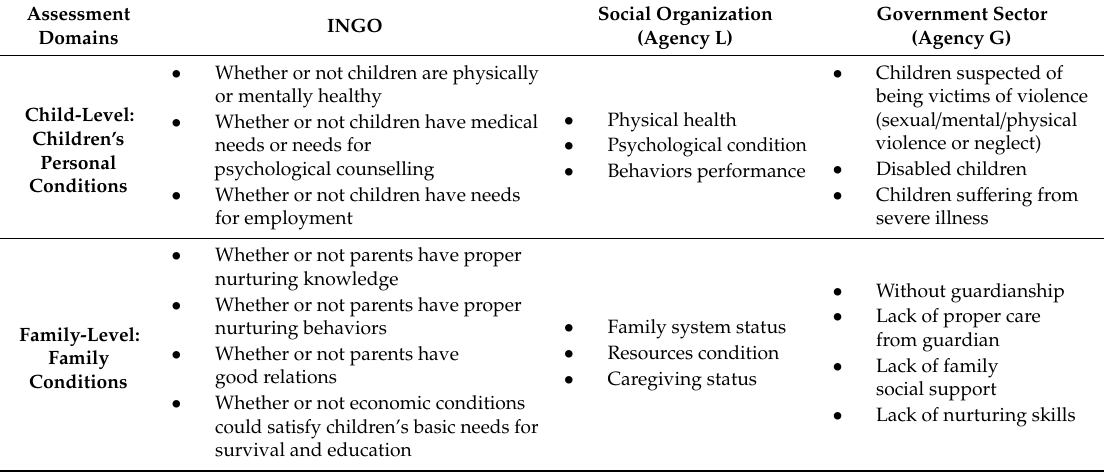
Table 3. Comparing assessment instruments by INGO, Agency L and Agency